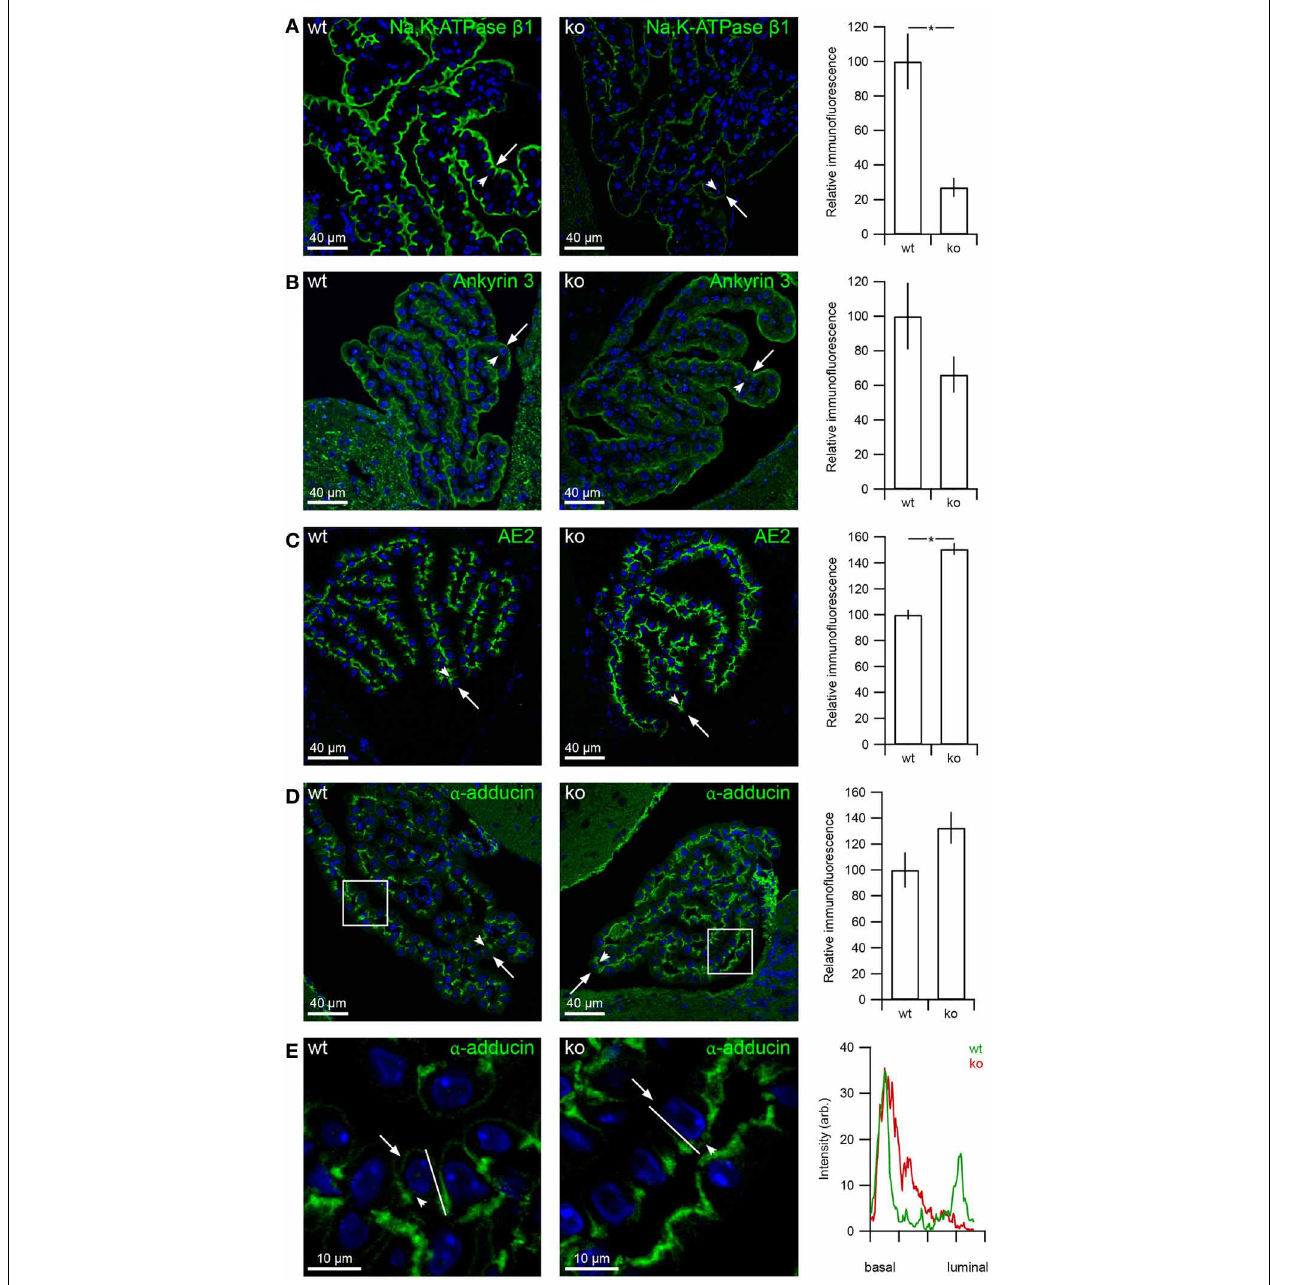
FIGURE 6 | β 1 Na + ,K + -ATPase and AE2 expression is changed in the CPE from slc4a10 ko mice. Mouse brain sections were immunostained for Na + ,K + -ATPase β 1 subunit, ankyrin-3, AE2, and α -adducin. (A) Immunohistochemical detection of β 1-Na + ,K + -ATPase in wt and ko, as indicated. Bar graphs on the right show the semi-quantitation of the respective immunofluorescence in slc4a10 wt and ko mouse CPE (wt: n = 5, ko: n = 3). (B) Immunostaining for ankyrin-3 in slc4a10 wt and ko, respectively. Bar graphs on the right show the semi-quantitation of the immunofluorescence in slc4a10 wt and ko mouse CPE (wt: n = 5, ko: n = 4). (C) Immunohistochemical detection of AE2 in slc4a10 wt and ko, as indicated. Bar graph on the right show the semi-quantification of